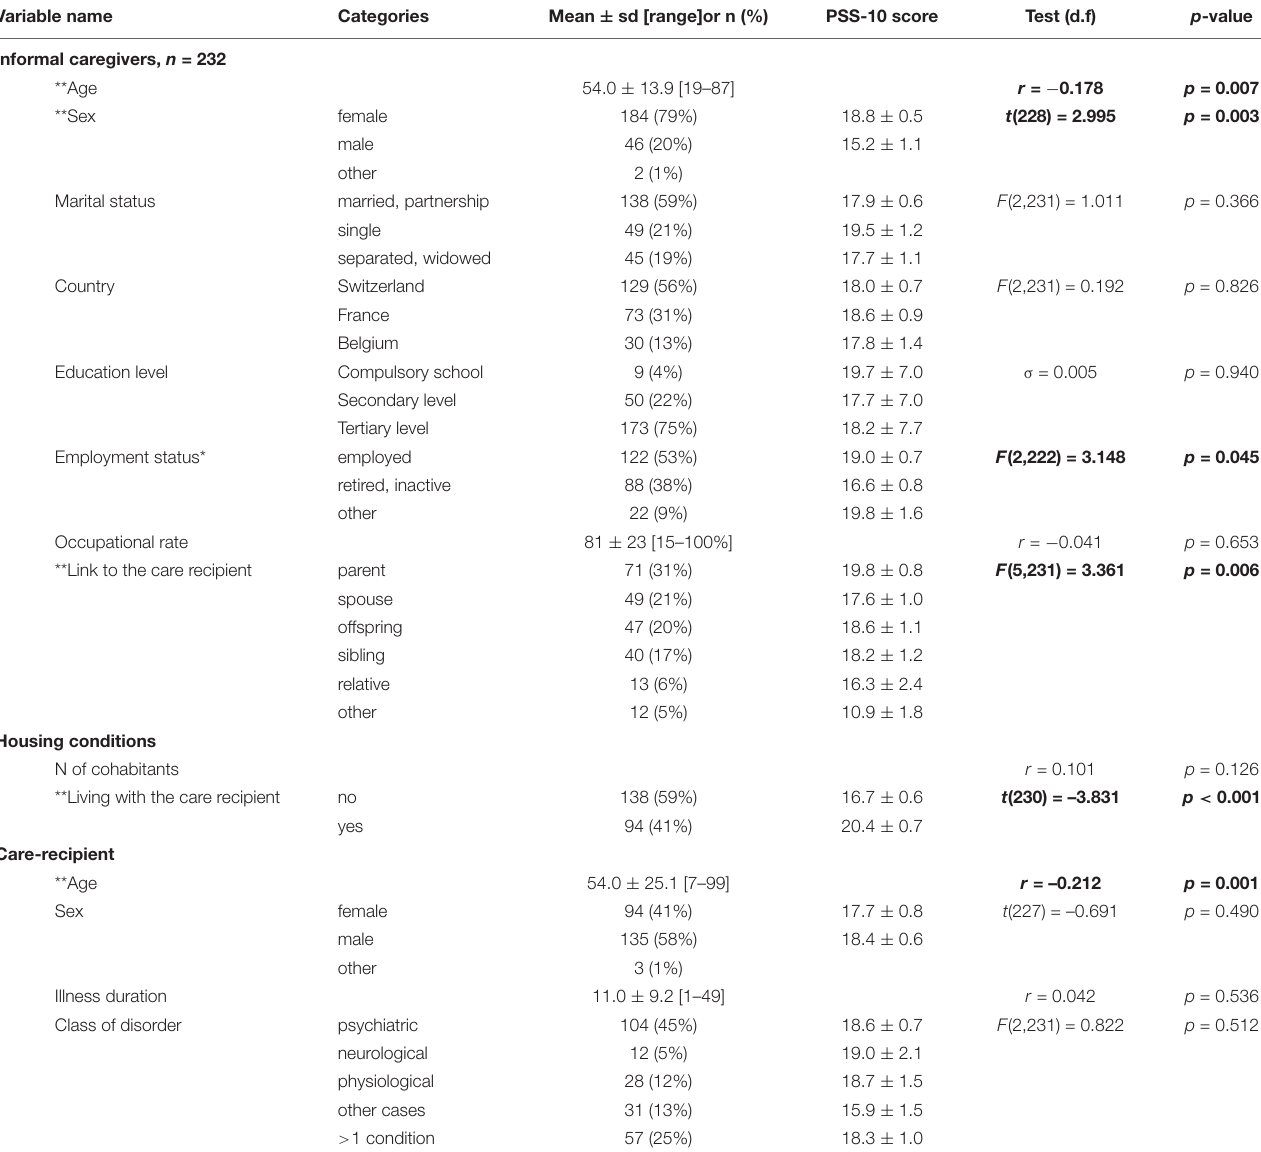
TABLE 1 | Sociodemographic variables and their association with perceived